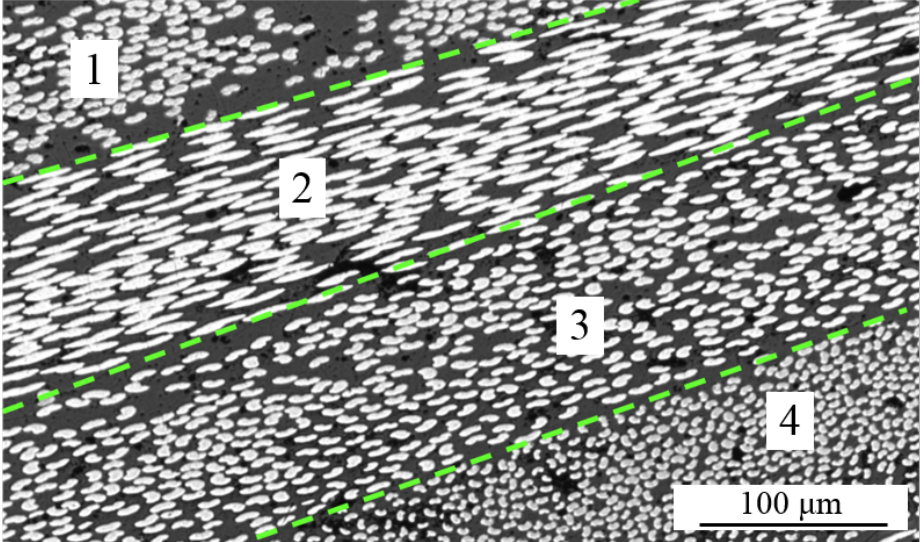
Figure 14. Microscope image with fiber groups with unknown fiber orientation.